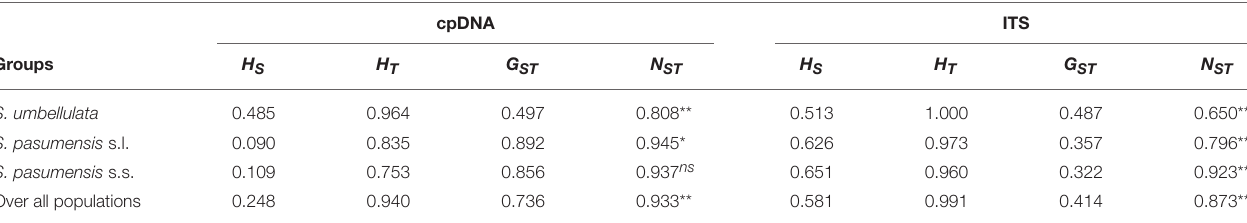
TABLE 2 | Estimates of average gene diversity within populations ( H S ), total gene diversity ( H T ), inter-population differentiation ( G ST ) and number of substitution types ( N ST ) for cpDNA haplotypes and ITS genotypes of Saxifraga umbellulata and S. pasumensis (s.l. and s.s.). cpDNA